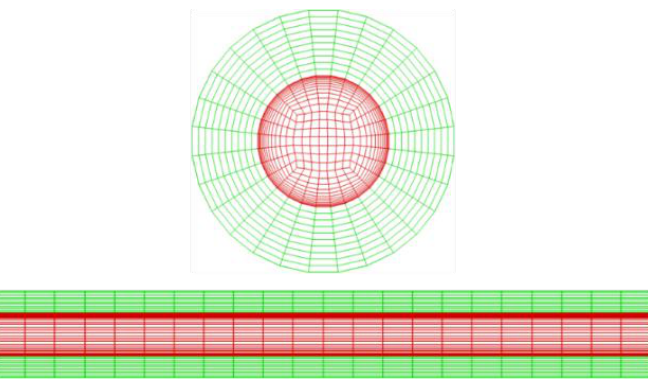
Figure 6. Computational domain and mesh of the pipe flow case.